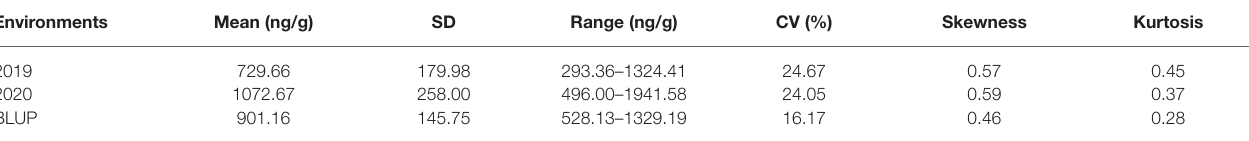
TABLE 1 | Summary of grain Mo concentration in 207 wheat